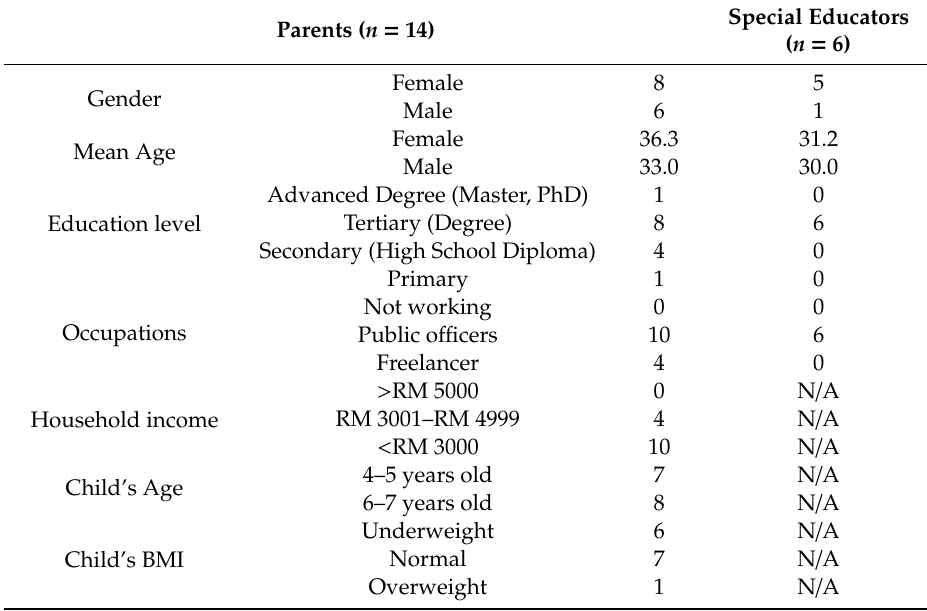
Table 2. Participants’ demographic